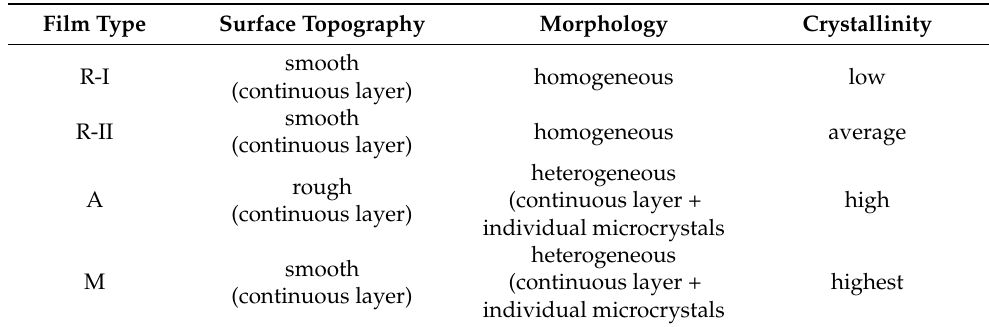
Table 2. Comparative features of surface topography, morphology, and crystal structure of the fabricated ZnO